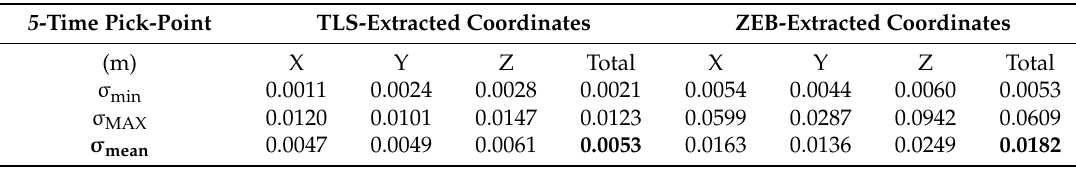
Table 8. The precision of coordinates derived from the test of the manual pick-point selection, statistically repeated five times on 20 points and applied on TLS and ZEB point cloud.